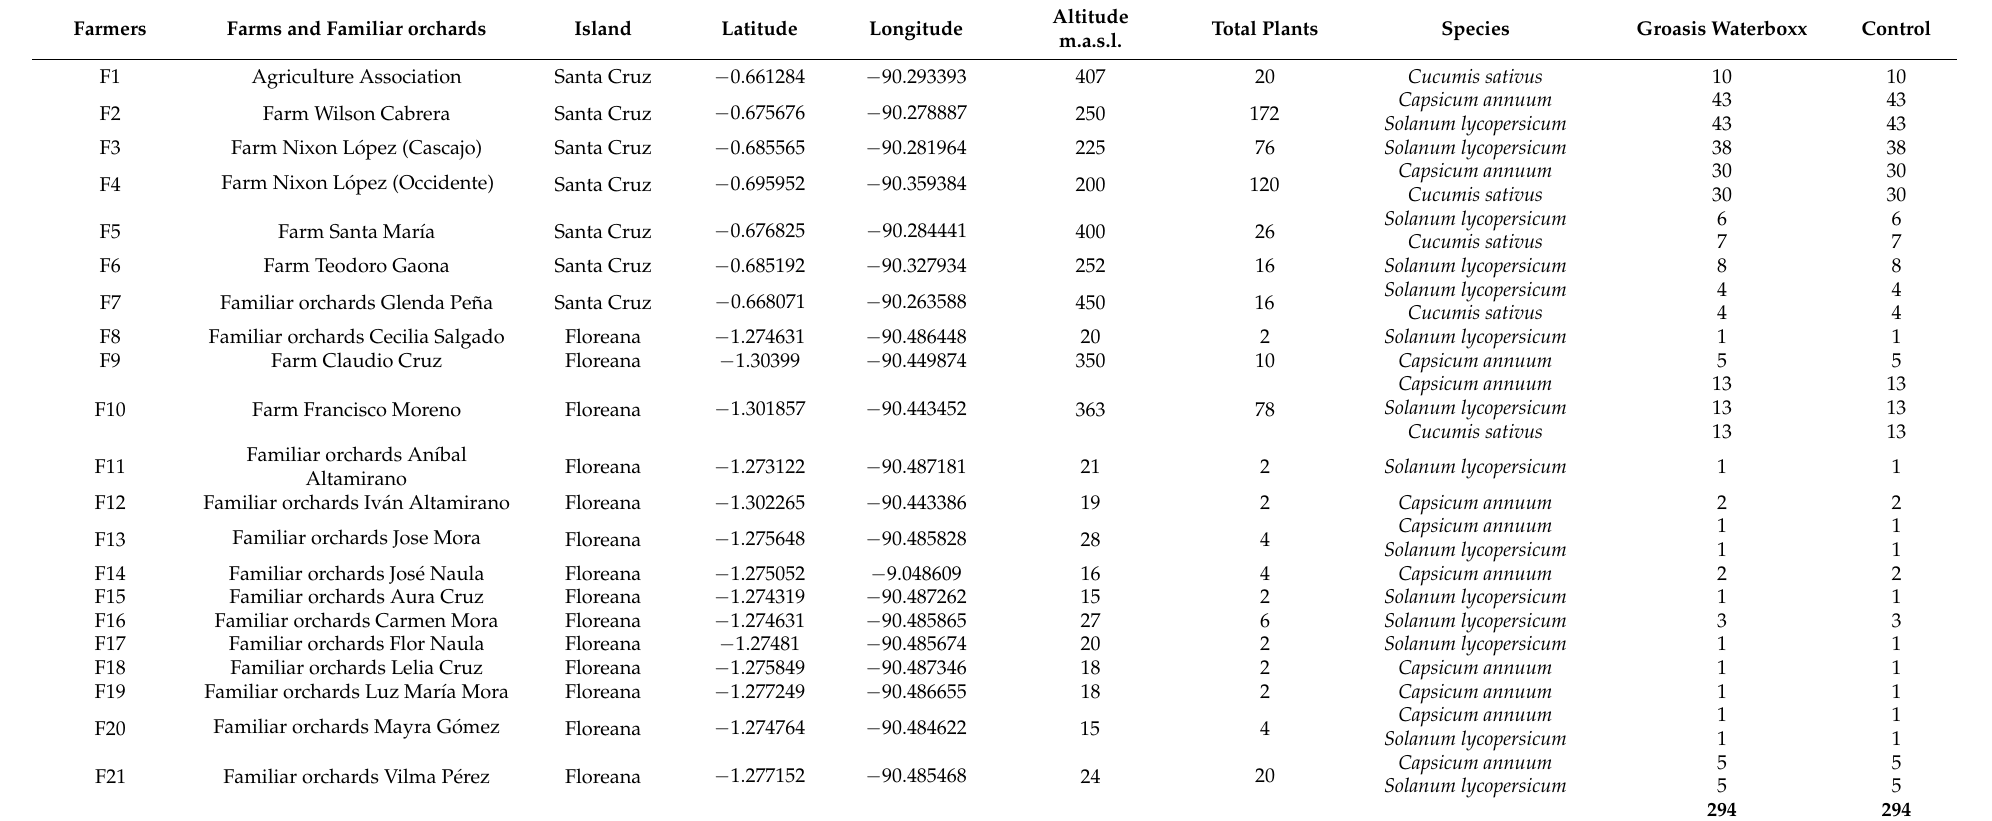
Table 2. Location and number of plants of each of the farmers and family garden who participated in the on-farm evaluation (2016–2018), using water saving technologies in five cultivated